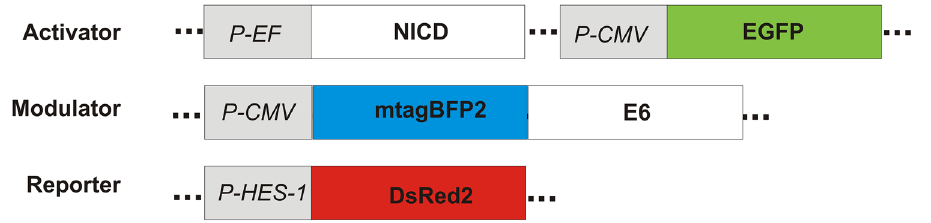
Figure 2. Constructs of triple fluorescence flow-cytometry-based assay to analyze P-HES1 activity. Three plasmids are co-transfected: (I) activator plasmid with two open reading frames encoding the Notch intracellular domain (NICD) as the activator of the Notch pathway and the EGFP as transfection control for the activator plasmid. (II) the modulator plasmid, encoding the modulator protein of interest E6, which is N-terminally fused to mTagBFP2 to monitor E6 expression. (III) the reporter plasmid encoding for the reporter DsRed2. The expression of DsRed2 is under control of the HES1 promotor which is regulated by the Notch pathway. Picture was created with CorelDRAW X7, version 17.5.0.907.